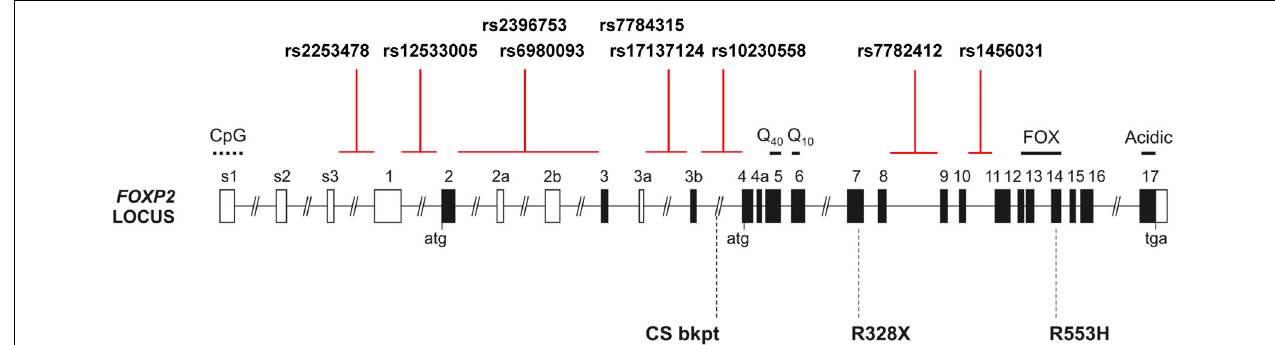
FIGURE 1 | The human FOXP2 locus. Schematic of the human FOXP2 locus, which spans > 600kb in chromosomal band 7q31, showing the intronic locations of candidate SNPs from prior studies of common variation. Black shading indicates translated exons; “atg” and “tga” denote positions of initiation and termination codons. Known domains encoded by exons include polyglutamine tracts (Q40 and Q10), the forkhead domain (FOX), and an acidic C-terminus. Exons 3b and 4a are alternatively spliced coding exons yielding amino acid insertions, whereas alternatively spliced exons 2a, 2b,